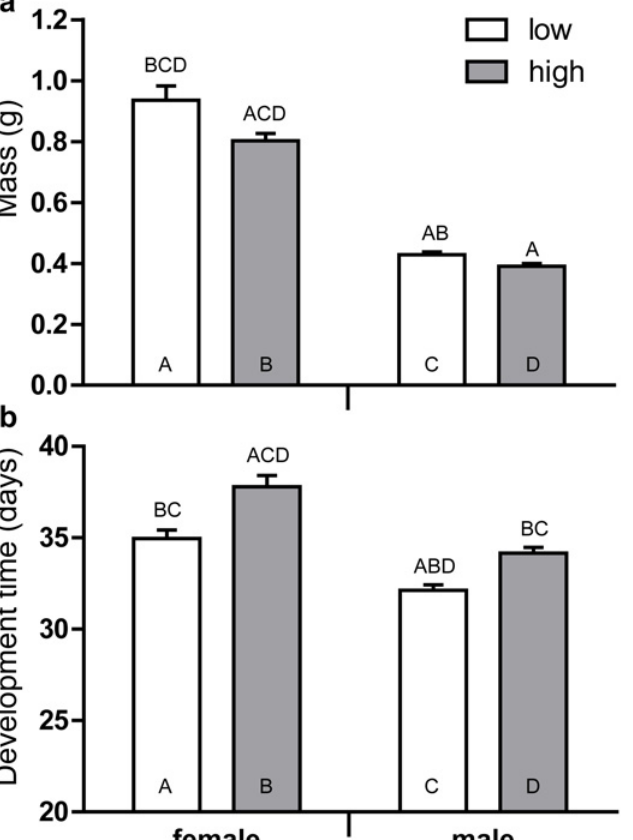
Fig 2. Effect of Betula pendula leaf surface lipophilic compounds on pupal weight and larval stage duration. The weight (mean ± SE) of pupae (a) and duration (mean ± SE) of larvae stage (b) of Lymantria dispar reared on Betula pendula leaves with low and high concentrations of surface lipophilic compounds is presented. The data were pair-wise compared using a post-hoc Fisher LSD procedure. The letters above the bar mean the significant differences (at P < 0.05) to be compared with the bars abbreviated by the same letters within the bar.